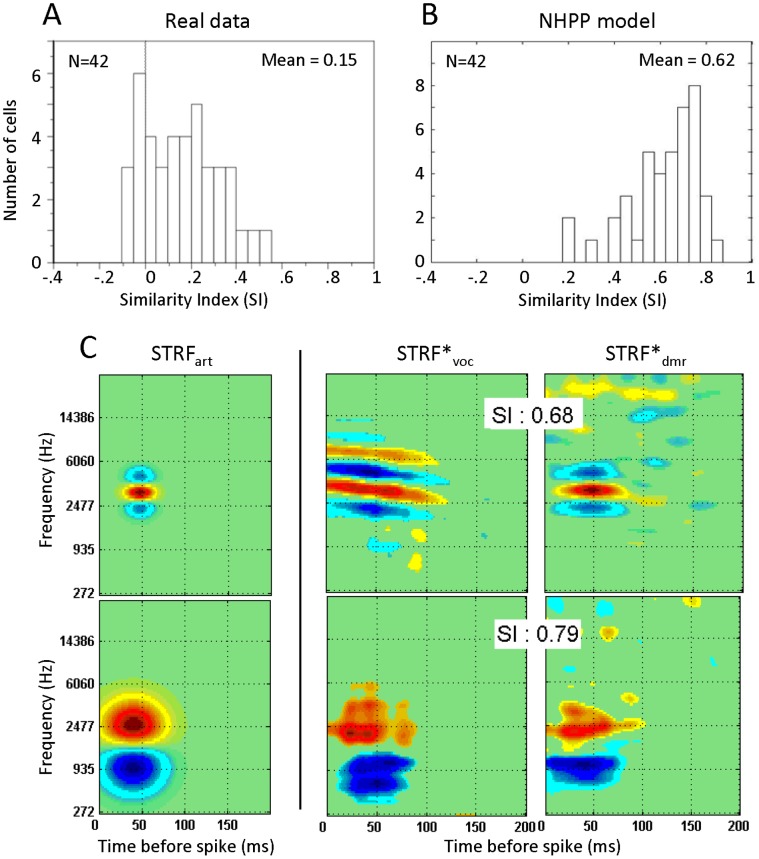
Comparisons between the similarity index (SI) obtained with the real and artificial neurons.A. Distribution of SI for the 42 neurons allowing for a paired-comparison between STRFvoc and STRFdmr. The mean SI of 0.15 is low and reflects important differences between the two types of STRFs. B. Distribution of SI for 42 STRF*s generated from the NHPP model responses. The mean SI of 0.62 reflects that STRF*s from vocalizations and DMRs show numerous similarities when calculated from the NHPP model’s responses. C. Two examples of STRFart (left) used to generate surrogate responses with the NHPP model and their associated estimated STRF*voc (middle) and STRF*dmr (right). The first example (top) displays a narrow excitatory zone surrounded by two inhibitory side bands. The second STRFart (bottom) is wider in spectral extent and has an inhibitory zone only in the low frequencies. Estimated STRF*s obtained from both sets of stimuli are quite similar with high SI values (0.68 and 0.79). Hence, the low SI values obtained from real data (A) cannot be attributed solely to differences in the statistics of our stimuli. STRF units and scale are the same as in Figure 2.